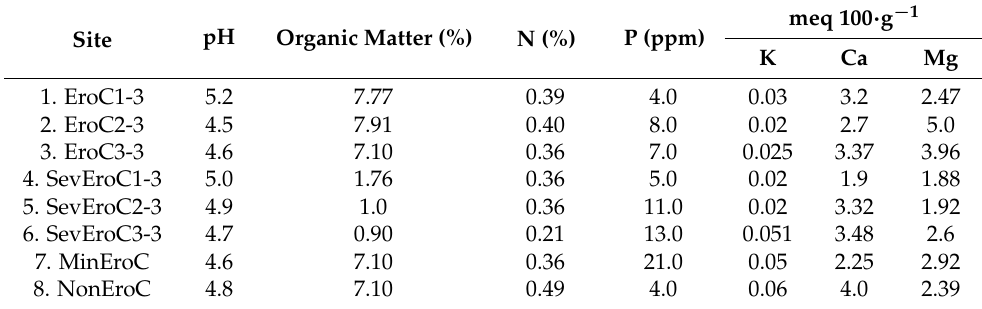
Table 1. Chemical soil parameters at field sites with different erosion